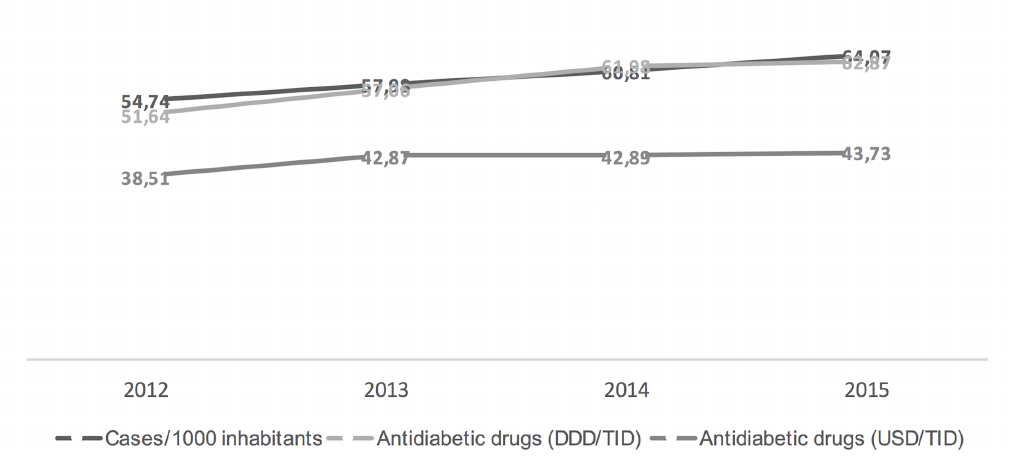
PLOS ONE | https://doi.org/10.1371/journal.pone.0178764 June 5,